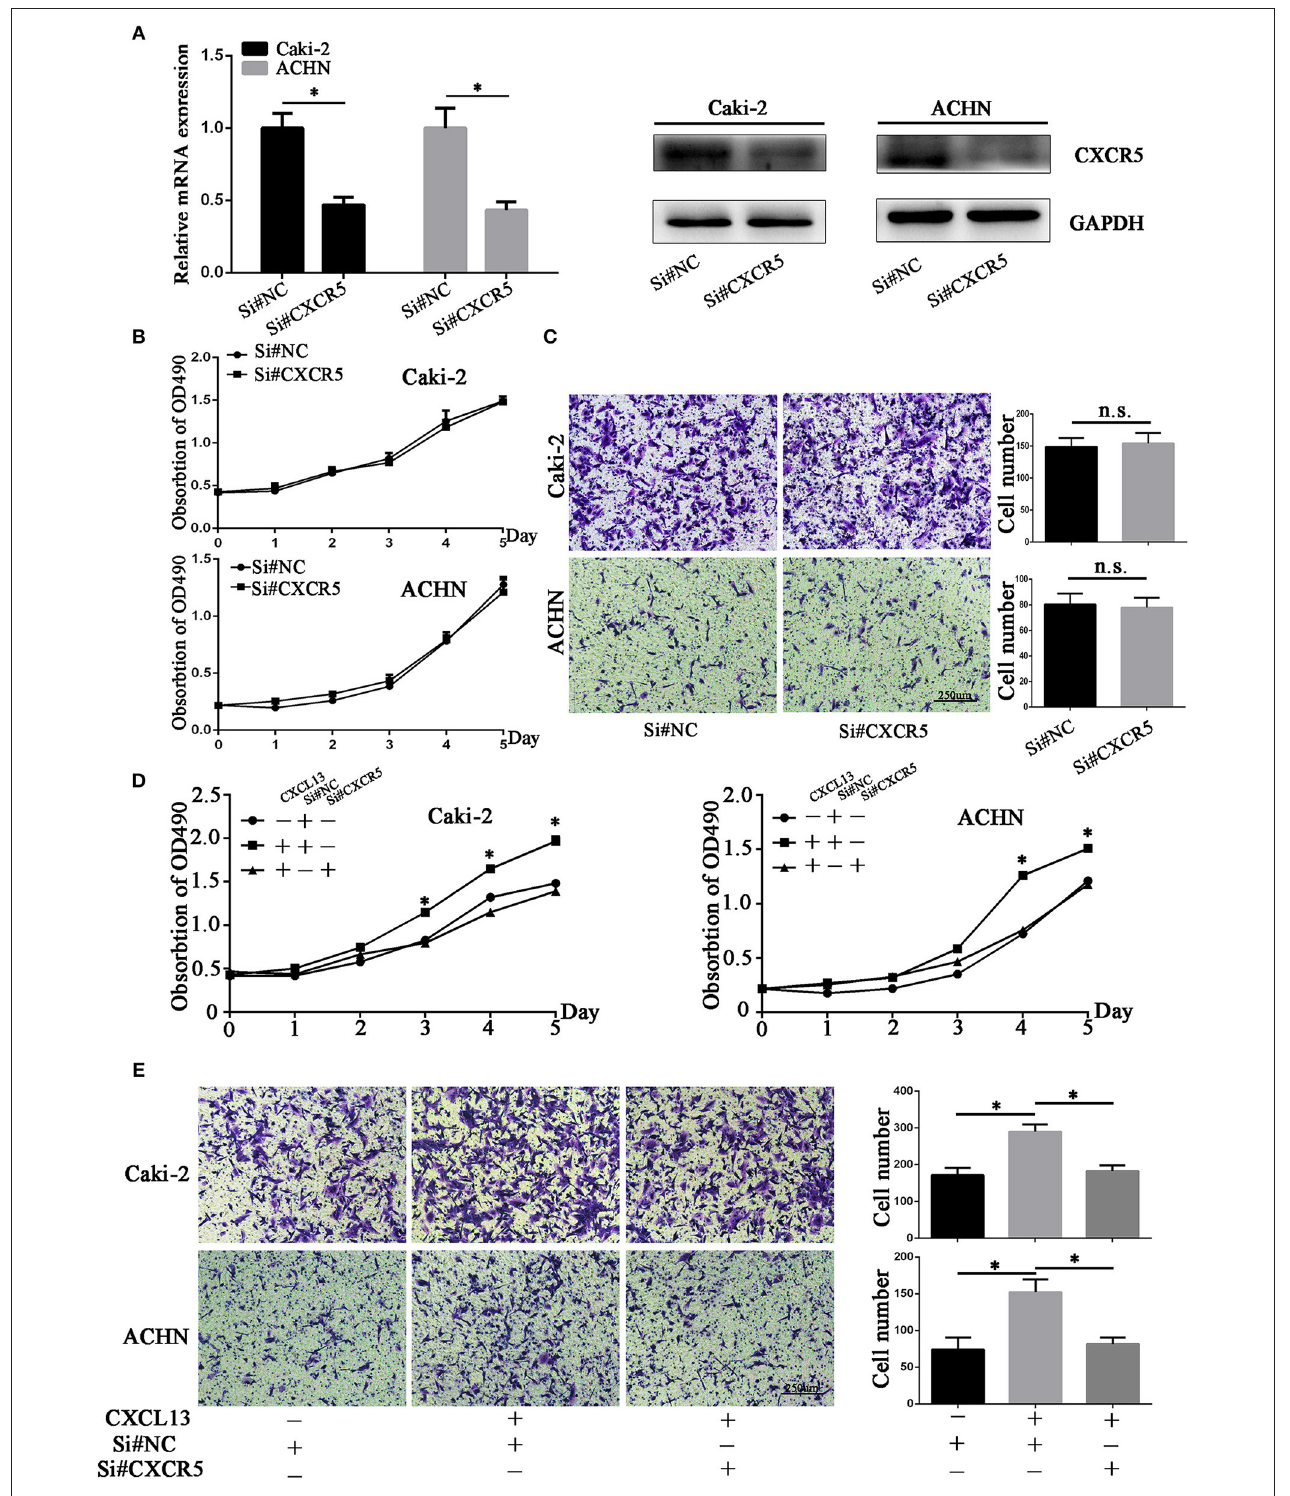
FIGURE 5 | CXCL13/CXCR5 axis promoted ccRCC cells proliferation and migration. (A) CXCR5 mRNA and protein expression in ccRCC cells after transfection with si#NC and si#CXCR5(Student’s t -test, * P < 0.05). (B) CXCR5 knockdown had no significant effect on proliferative ability in ccRCC cells. (C) CXCR5 knockdown had no significant effect on migratory ability in ccRCC cells. (D) CXCR5 knockdown inhibited the CXCL13-mediated cell proliferation in ccRCC cells as determined by CellTiter 96 Aqueous One Solution Cell Proliferation Assay (Student’s t -test, * P < 0.05). (E) CXCR5 knockdown inhibited the CXCL13-mediated cell migration in ccRCC cells as determined by transwell migration assays (Student’s t -test, * P < 0.05).